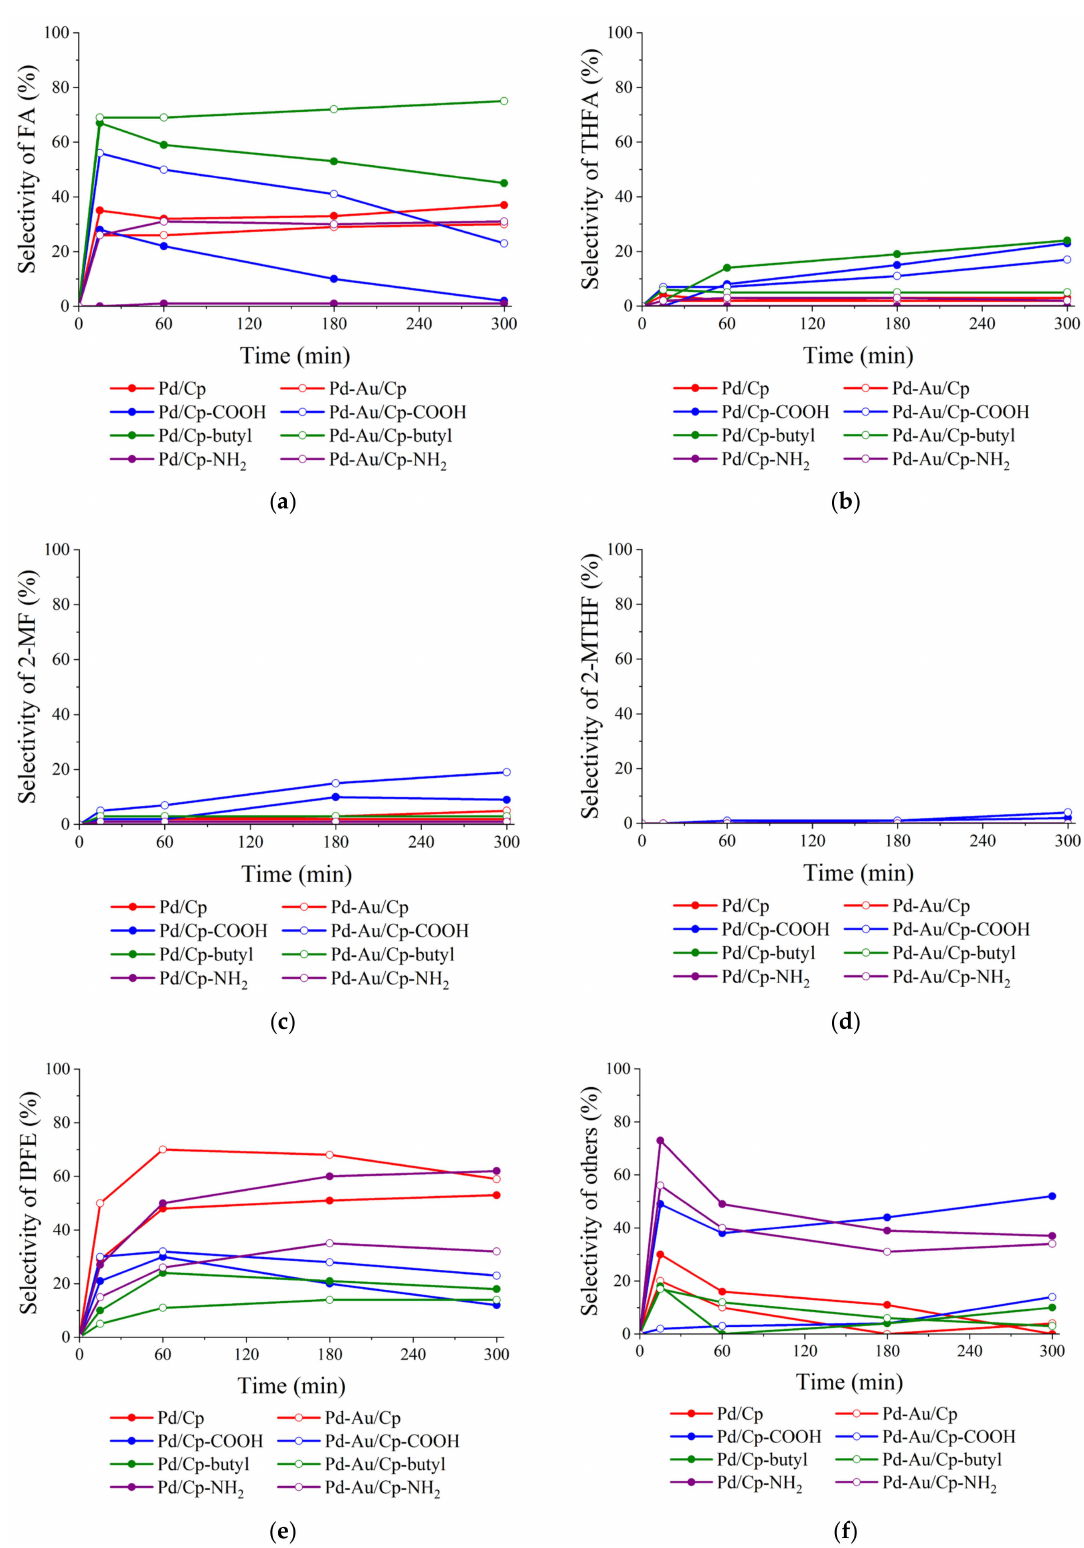
Figure 9. Time evolution of catalytic hydrogenation of furfural: ( a ) furfuryl alcohol; ( b ) tetrahy- drofurfuryl alcohol; ( c ) 2-methylfuran; ( d ) 2-methyltetrahydrofuran; ( e ) isopropyl furfuryl ether; ( f ) others. Reaction conditions: 0.3 M furfural (0.2882 g) in 10 mL 2-propanol, amount of catalyst 0.0645 g (Pd/furfural = 1:500 mol/mol; Pd-Au/furfural = 1:580 mol/mol), T = 50 ◦ C, pH 2 = 5 bar, t = 5 h, stirring 1000